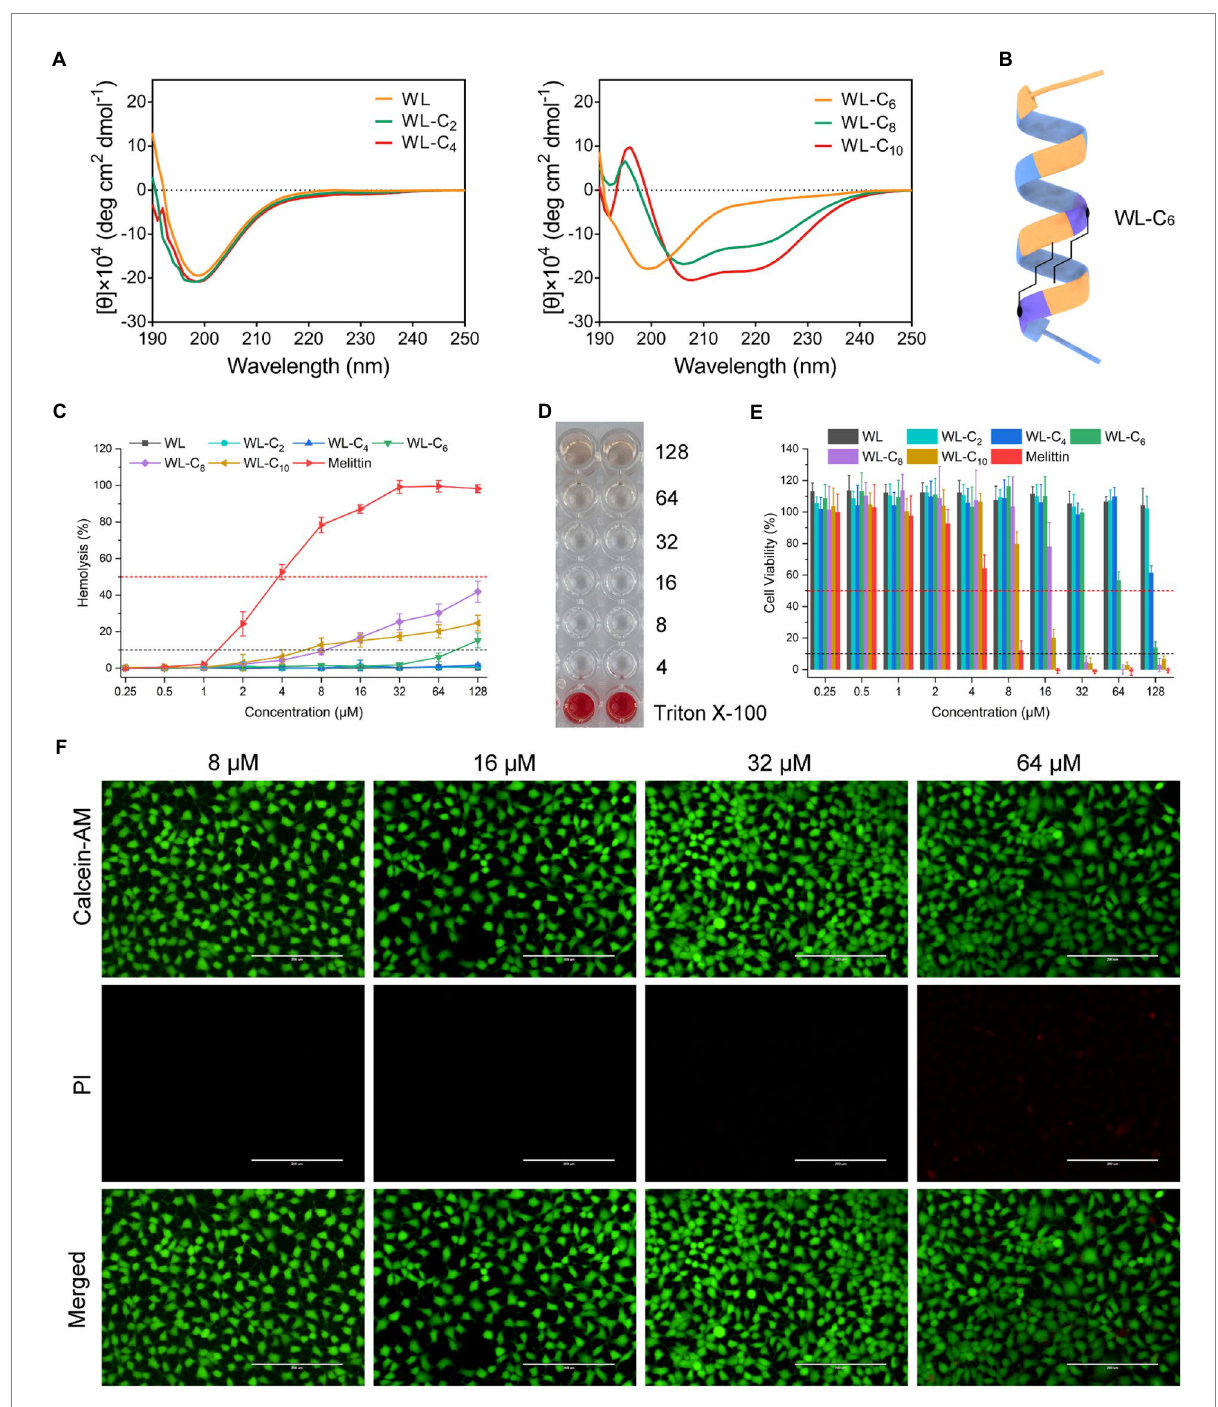
FIGURE 2 (A) CD spectra of the peptides in 10 mM PBS. (B) Model ribbon views of WL-C 6 . (C) Hemolytic activity of the peptides against hRBCs. Melittin was used as a control peptide. Data: mean ± standard deviation (SD; n = 6). (D) Hemolytic activity of WL-C 6 (4–128 μ M) against hRBCs. Erythrocyte suspension containing 0.1% TritonX-100 were used as a positive control. Data: mean ± SD ( n = 6). (E) Cytotoxicity of the peptides against HEK293T. Melittin was used as a control peptide. (F) Live/dead cell staining images of HEK 293 cells after treating with WL-C 6 and staining with PI (red) and Calcein-AM (green). Scale bar: 200 μ